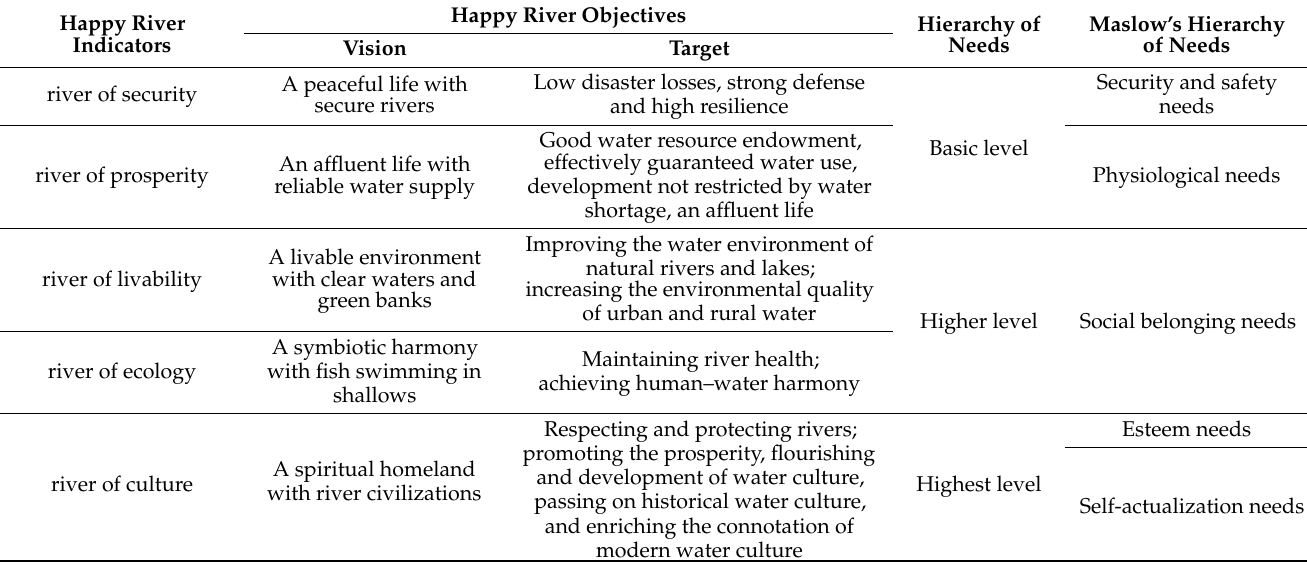
Table 1. Hierarchical framework of a happy